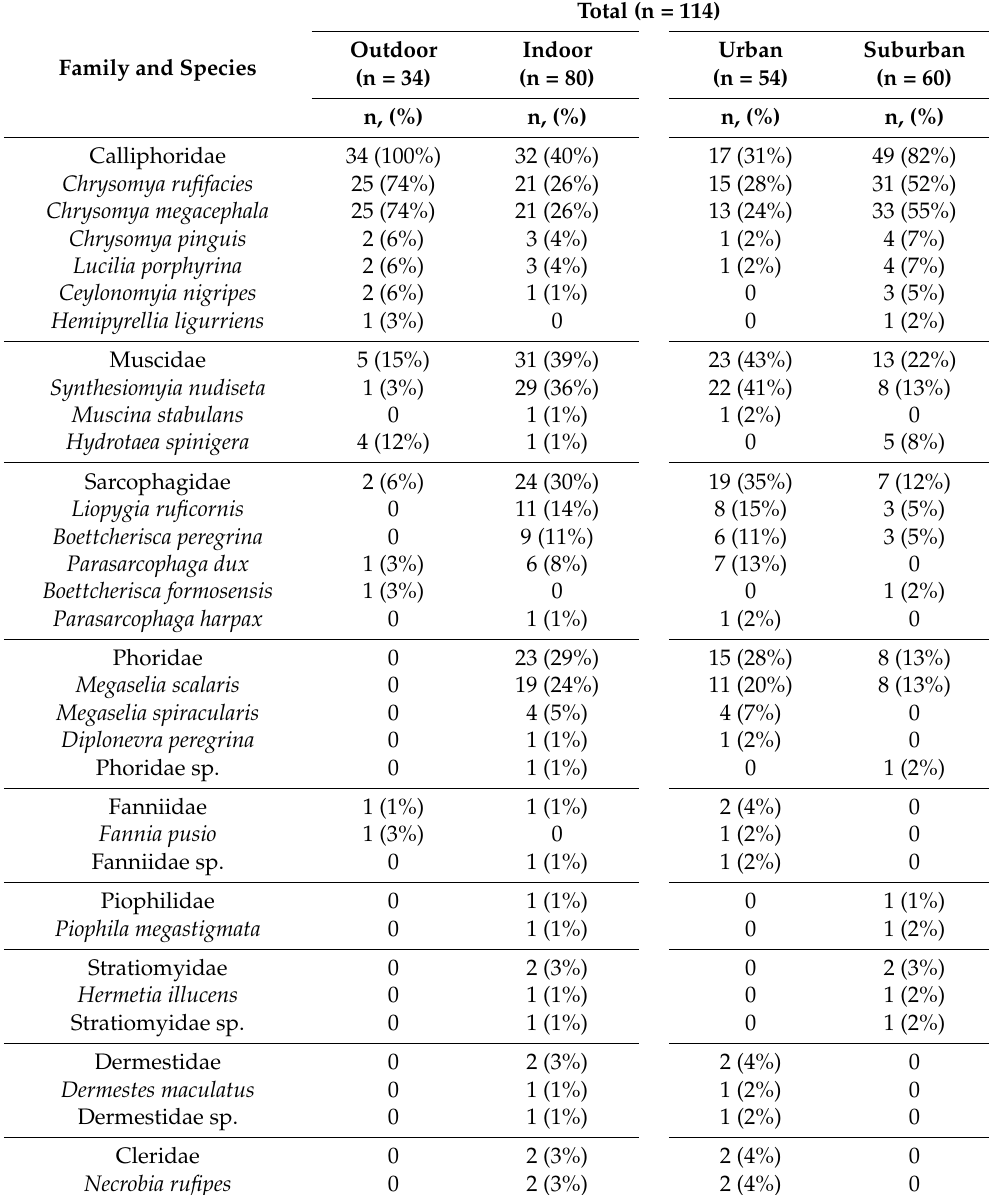
Table 1. Case frequency of fly species collected from 114 forensic cases in indoor/outdoor and urban/suburban in Taiwan from 2011 to 2018. (n, number of